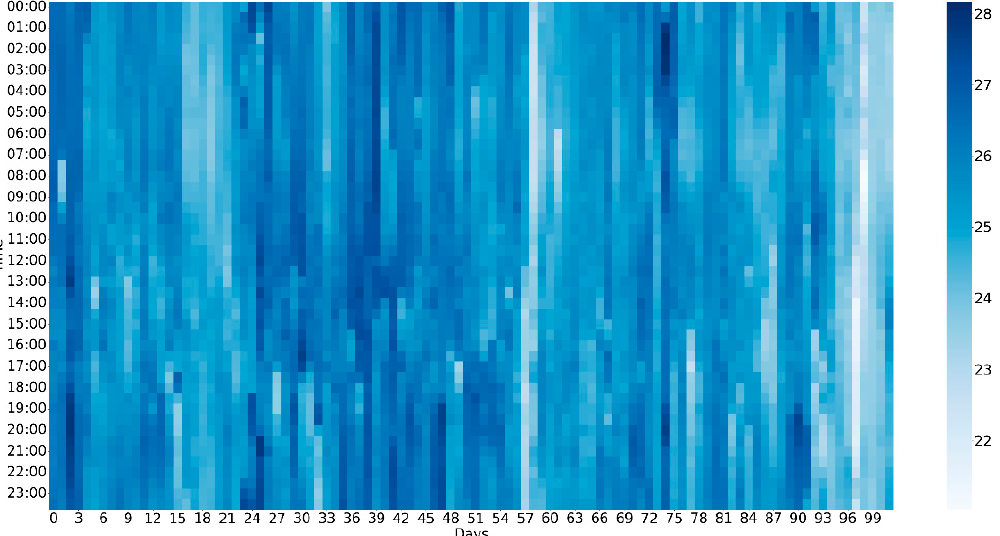
Figure 6. The temporal distribution of the wet-bulb temperature. The deeper the color, the higher the temperature.